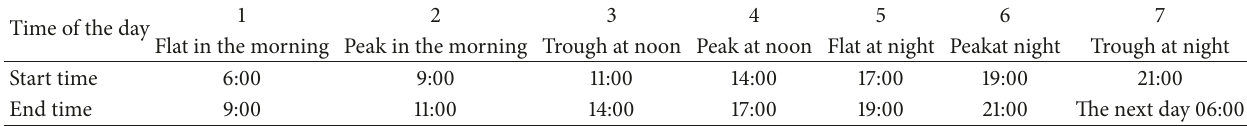
Table 4: Time of division in one day.